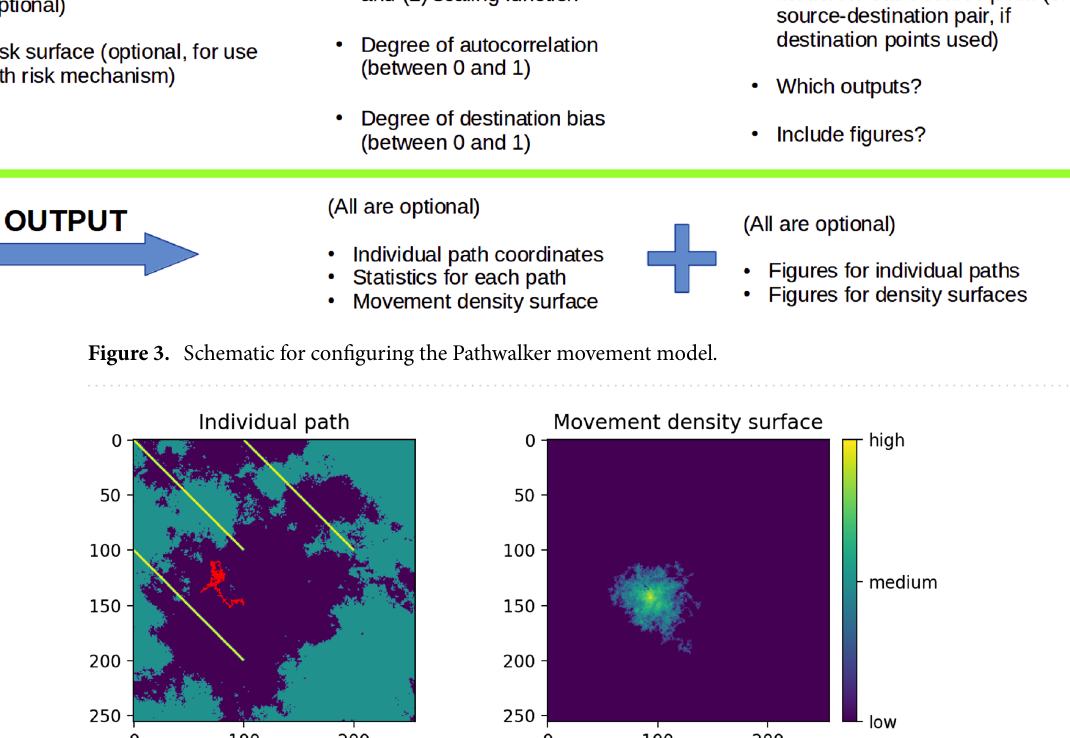
Figure 4. On the left, an example individual stochastic path in red on the fourth resistance surface used in this analysis; yellow is high resistance and blue is low resistance. On the right, an example density surface produced by aggregating 100 paths from the same source point and with the same movement parameters; yellow is high density and blue is low